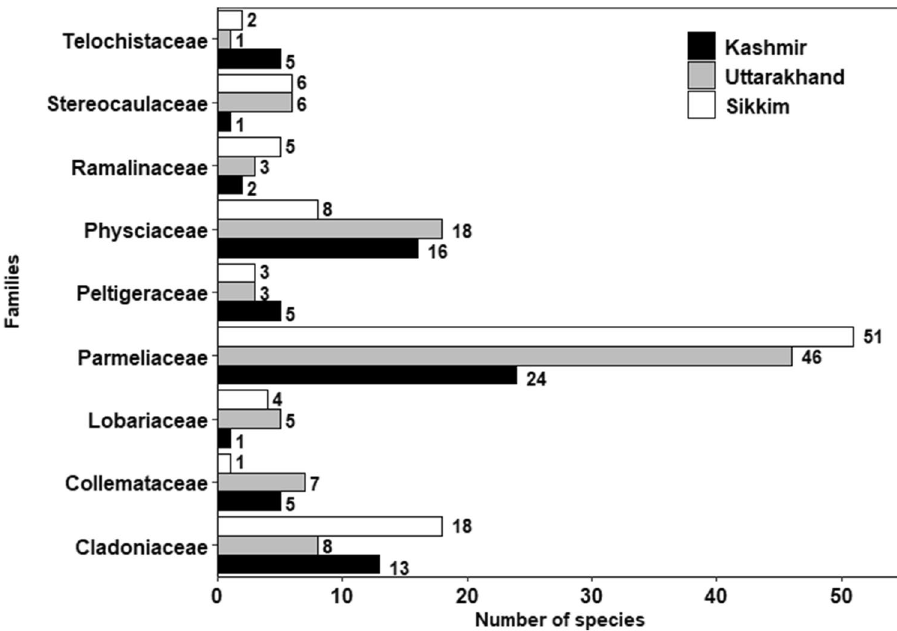
Figure 6. Nine largest families of macrolichens in Kashmir, Uttarakhand and Sikkim.